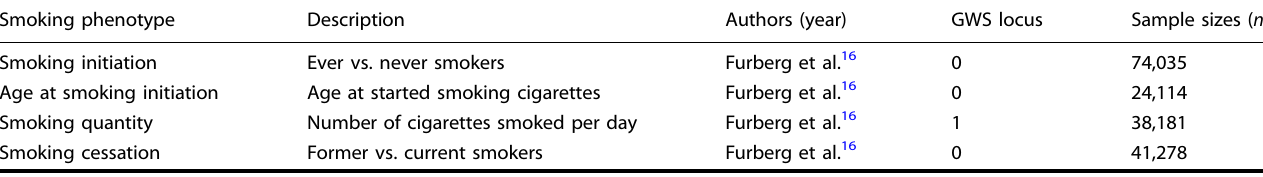
Table 1. Sample sizes for European-based discovery GWASs of four smoking-related intermediate